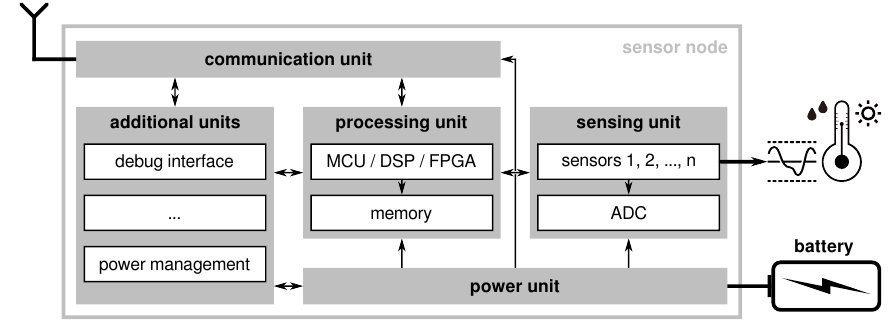
Figure 8. Basic components of a wireless sensor node (after Figure 1 in